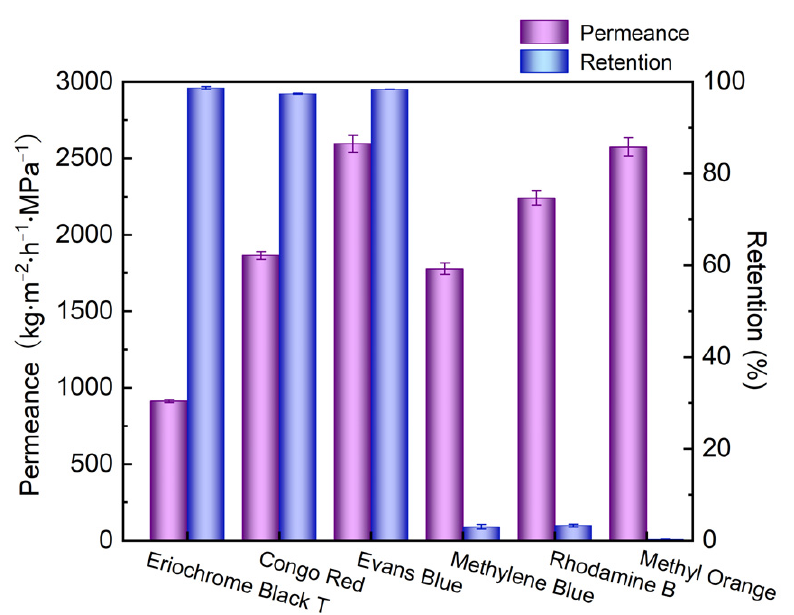
Figure 7. Separation performance of the CNTs/LDH membrane for different dyes (preparation conditions: 0.1 g/L LDH, 2 wt.% CNT; operating pressure: 0.1 MPa).